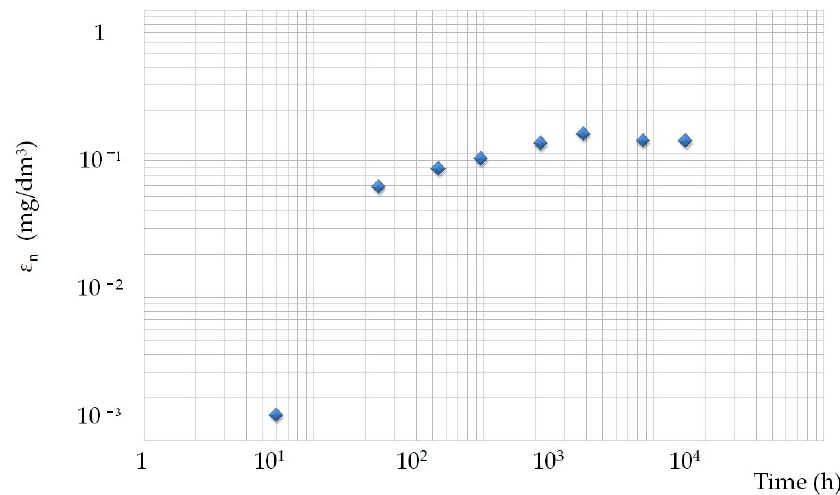
Figure 10. Total leachability of strontium from the opoka rock over time. ♦ —average leachability of Sr from opoka rock (mg/dm 3 ) .